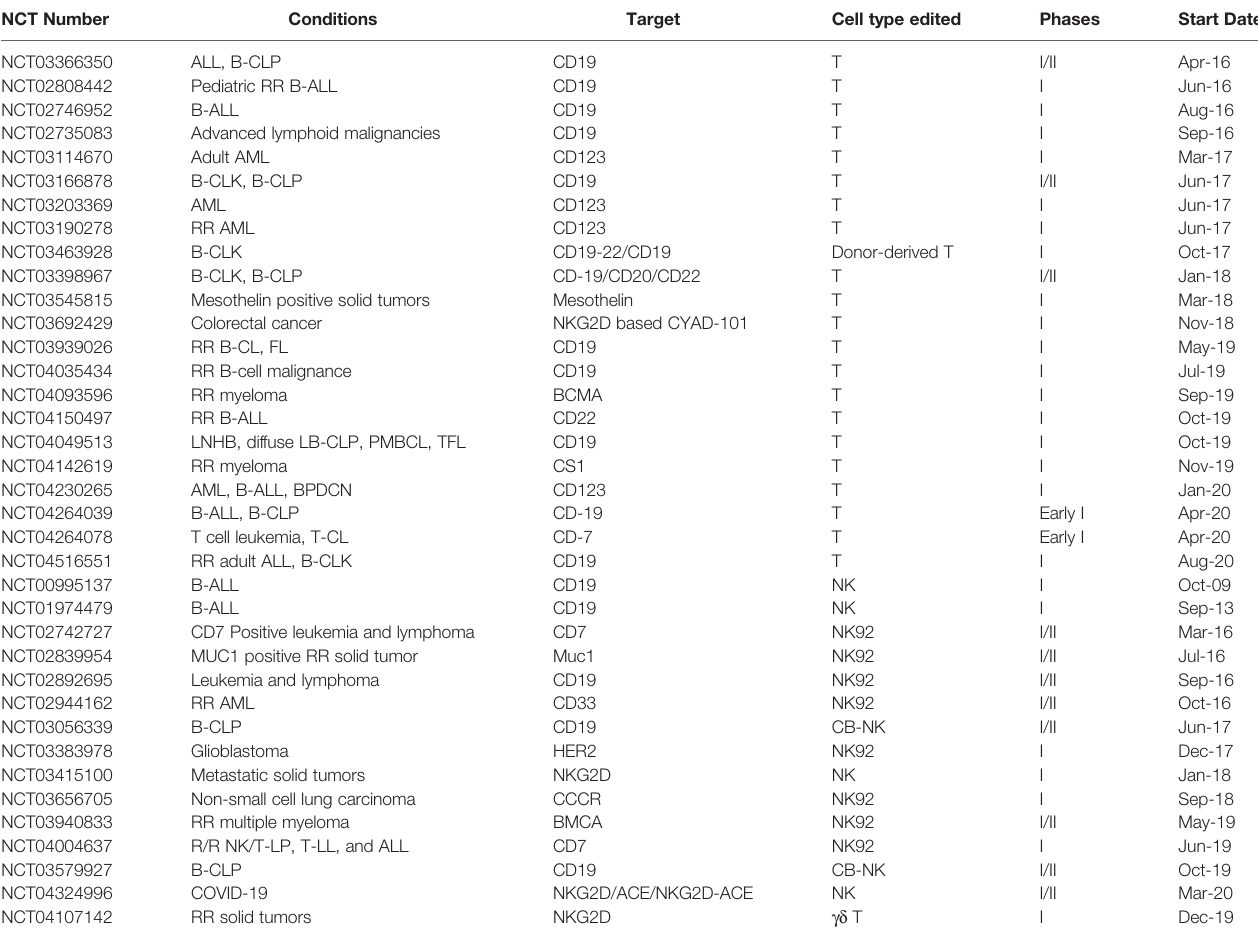
TABLE 1 | Current clinical trials of UC